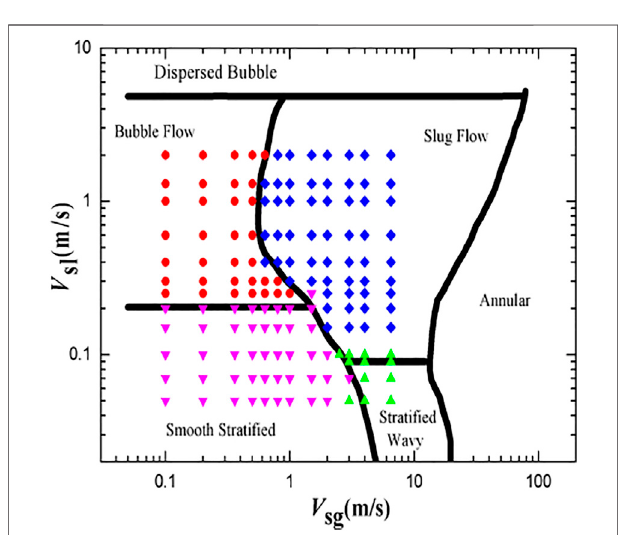
FIGURE 8 | Comparison between fl ow pattern simulations and Mandhane fl ow pattern diagram.